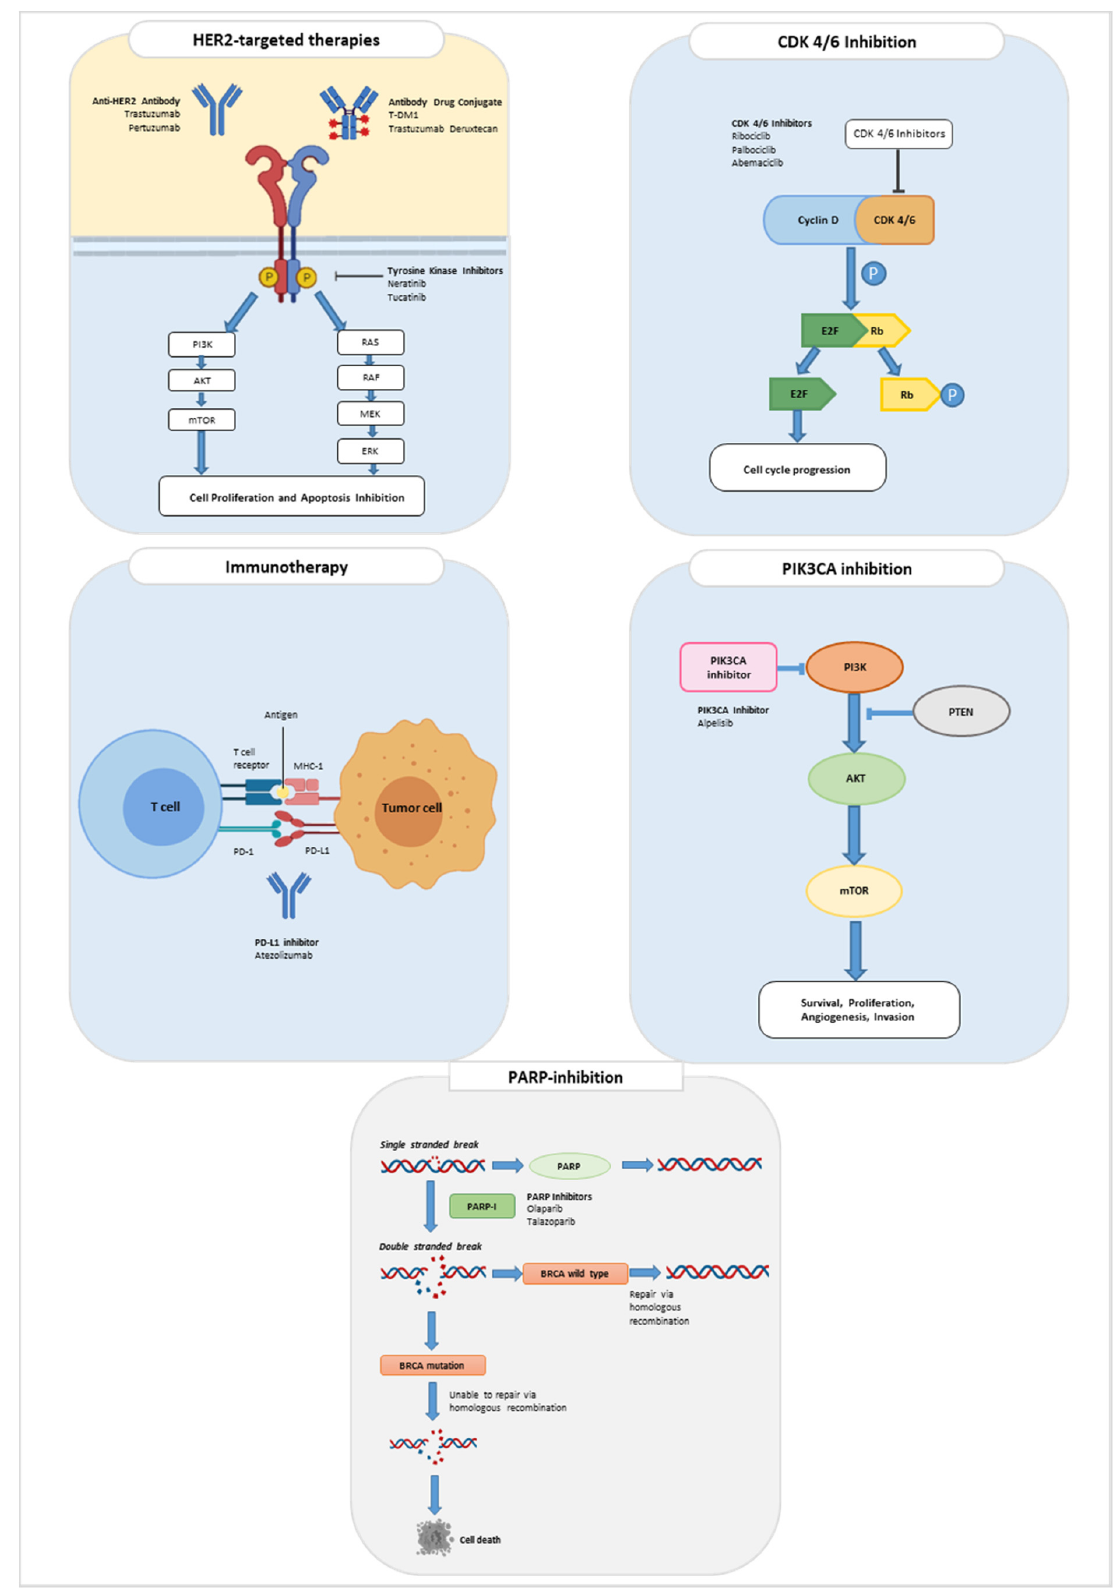
Figure 1. Therapeutic targets of new drugs approved for the treatment of breast cancer. In this figure, the mechanism of action of new approved drugs is shown. In particular, the new approved therapies belong to the category of HER2-targeted drugs, CDK 4/6 inhibitors, immunotherapy, PIK3CA inhibitors, and PARP inhibitors.